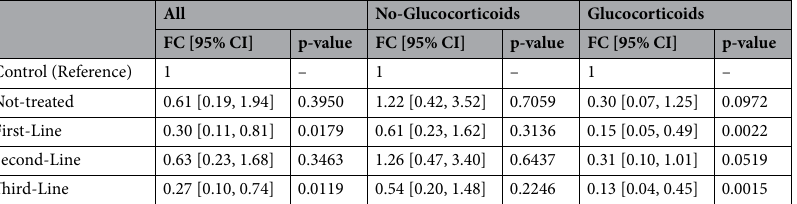
Table 3. Neutralizing antibody (nAB) levels of Systemic Lupus Erythematosus (SLE) patients after SARS- CoV-2 vaccination compared to Healthy subjects. Table cells show the Fold-Changes (FC), 95% Confidence Intervals (95% CI) and p-values derived from comparing antibody titers between each treatment line group and the Healthy subjects, which are taken as reference. Comparisons are performed for subjects receiving and not currently receiving Glucocorticoids’ therapy (Corticoids and No-Corticoids columns), as well as for all patients overall (All columns). Estimations and p-values are derived from a linear model in which sex, age, time from vaccination, vaccine type and corticoids therapy were included as covariates for statistical control. FC: Fold-change; 95% CI: 95% confidence interval.